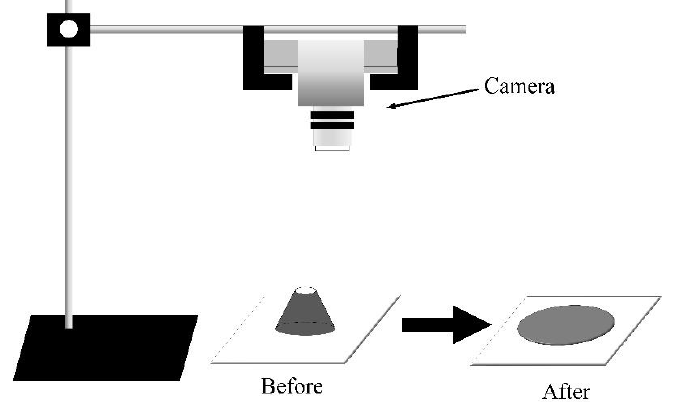
Figure 2. Schematic diagram of fluidity test.